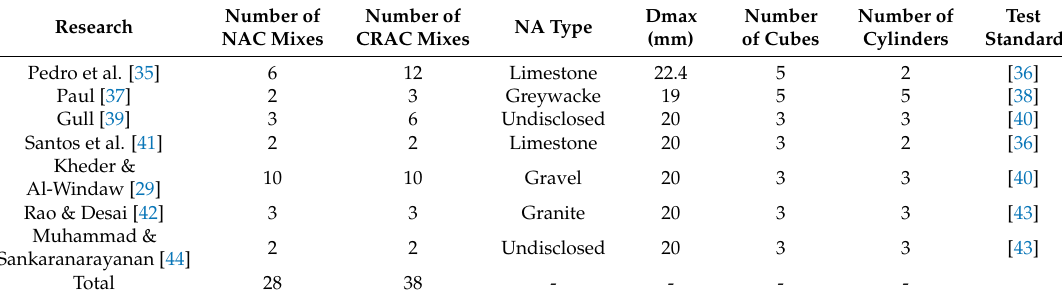
Table 1. Number and origin of the mixes